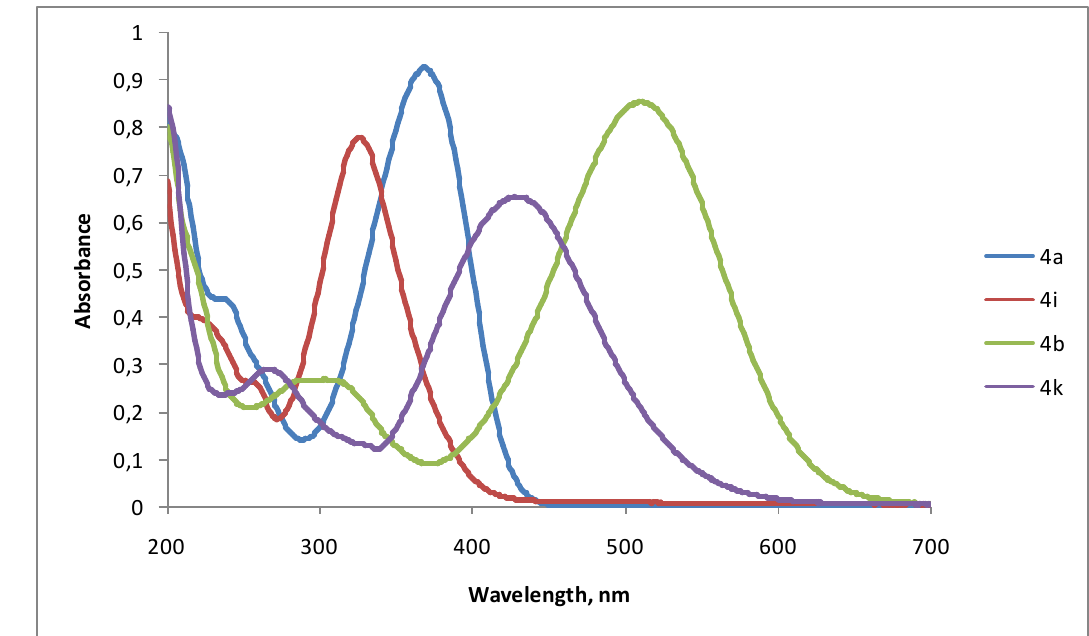
Figure 6. UV – Vis spectra of compounds 4a – c in MeCN (2 × 10 −5 M). On the other hand, the replacement of 5-NO 2 with the CF 3 group in a pyridine cycle caused a 42 nm blue shift for compounds 4a / 4i and an 80 nm shift for 4-dimethylaminophenyl derivatives 4b / 4k , as well as a small decrease in molar absorp- tivity (Figure 7). It can be concluded that substituents at the double bond as well as in position 5 can be independently altered to predictably fine-tune absorption spectra of these compounds. Molecules 2022 , 27 , x FOR PEER REVIEW